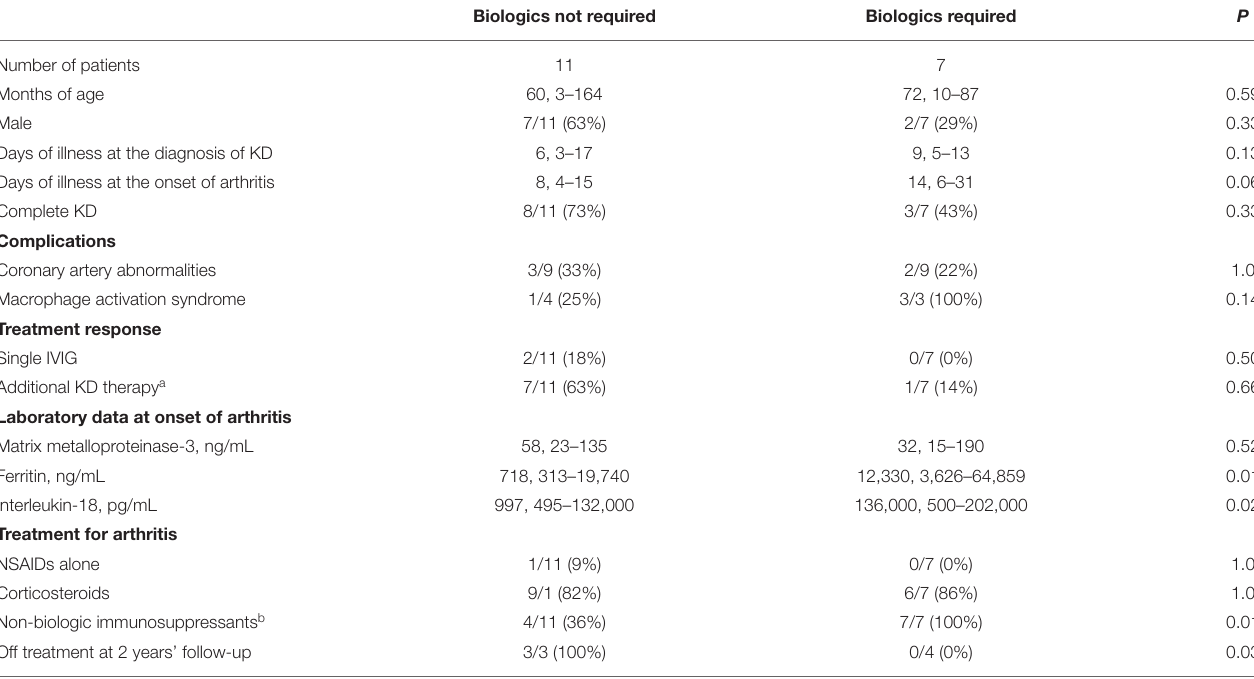
TABLE 5 | Clinical characteristics of the continued fever-onset patients who required biologics for arthritis control and those who did not.